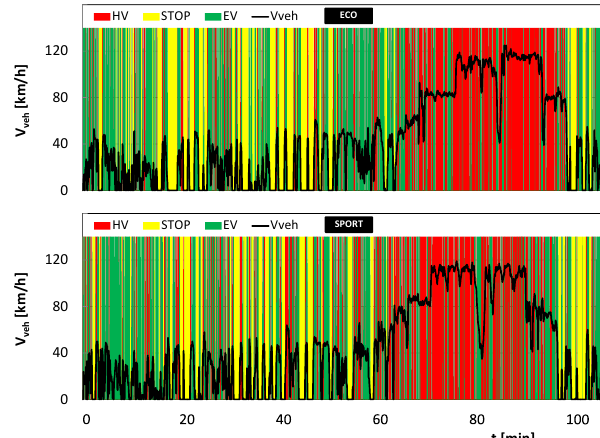
Fig. 8. The performed tests characteristics with a distinction between operation in hybrid and electric modes as well as vehicle stop